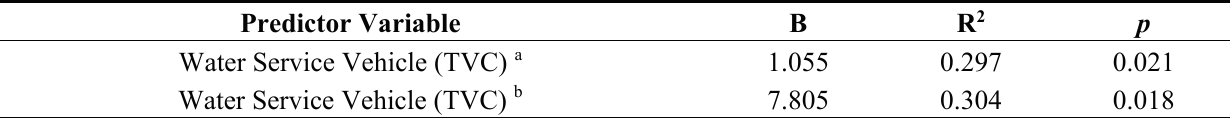
Table 10. Linear Regression coefficients for two Linear Regression models for sampling activity